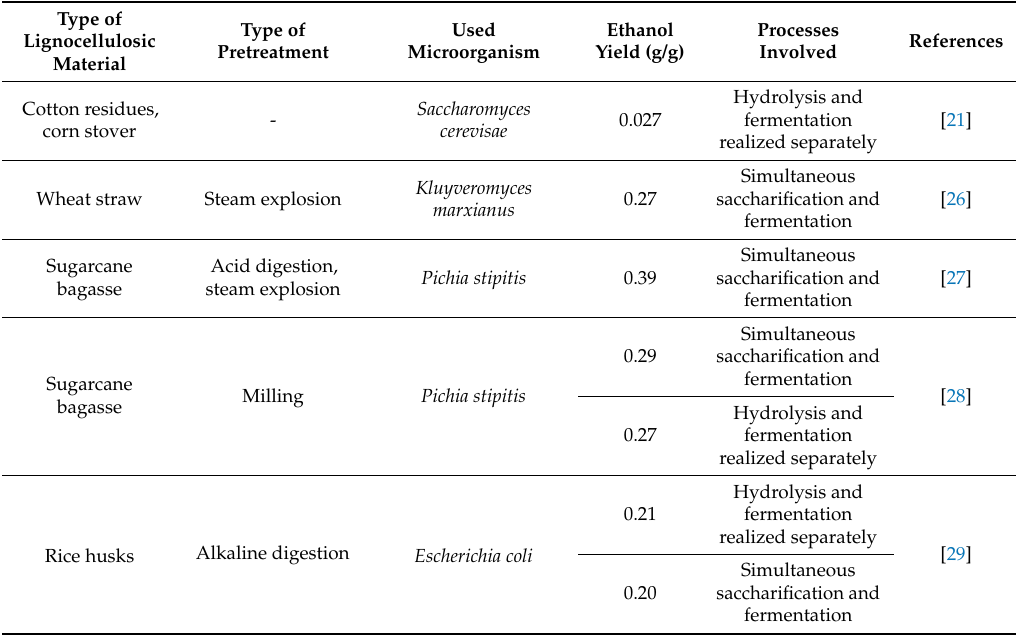
Table 1. The efficiency of bioethanol production related to the pre-treatment method and used microorganisms. Table 1.